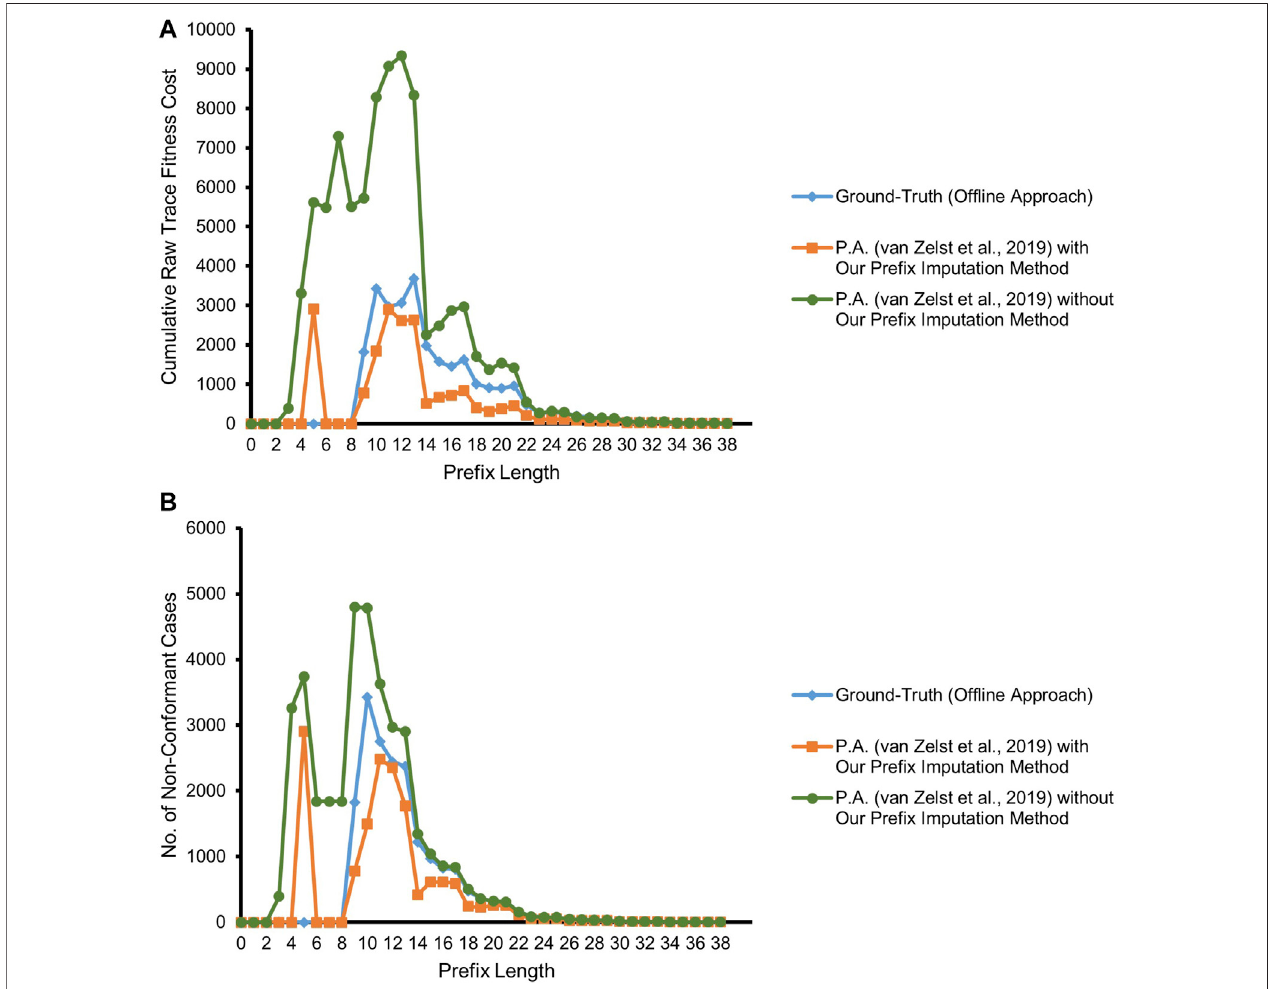
FIGURE 9 | Pre fi x-alignments with and without our pre fi x-imputation method for the application process and its offer sub-process of the BPIC ’ 12 event data. (A) Cumulative raw trace fi tness cost. (B) Number of non-conformant cases.